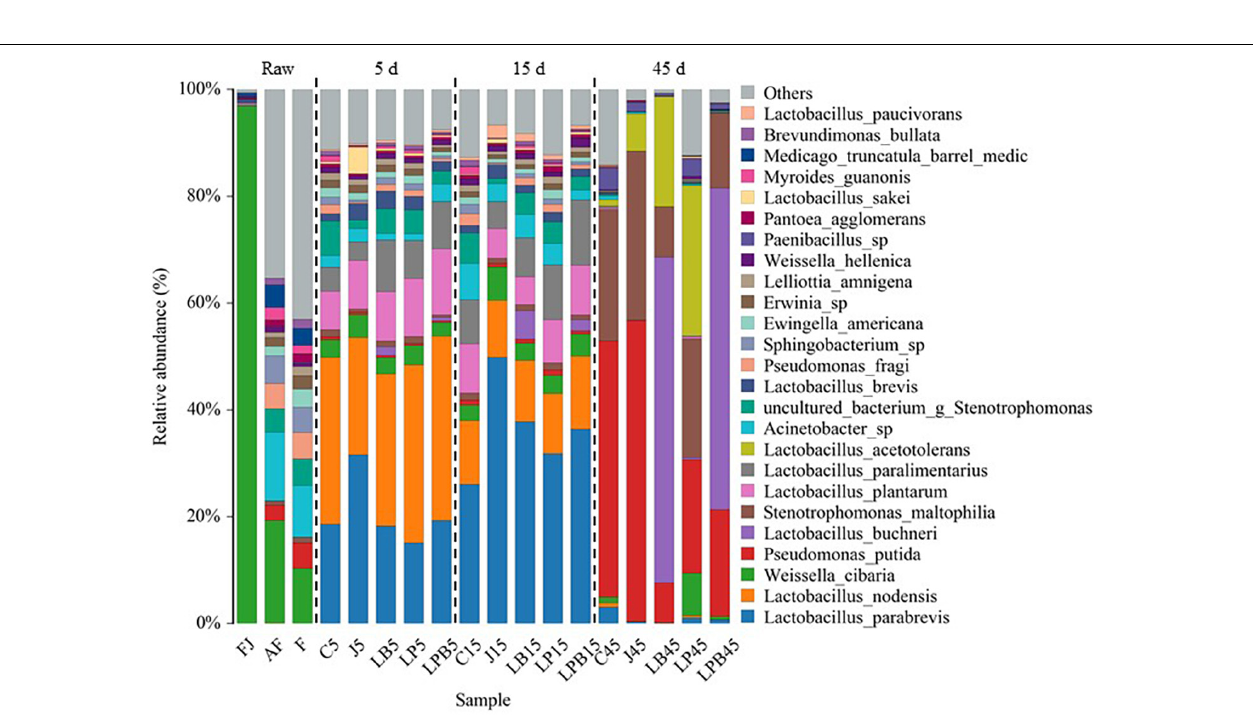
Frontiers in Microbiology |